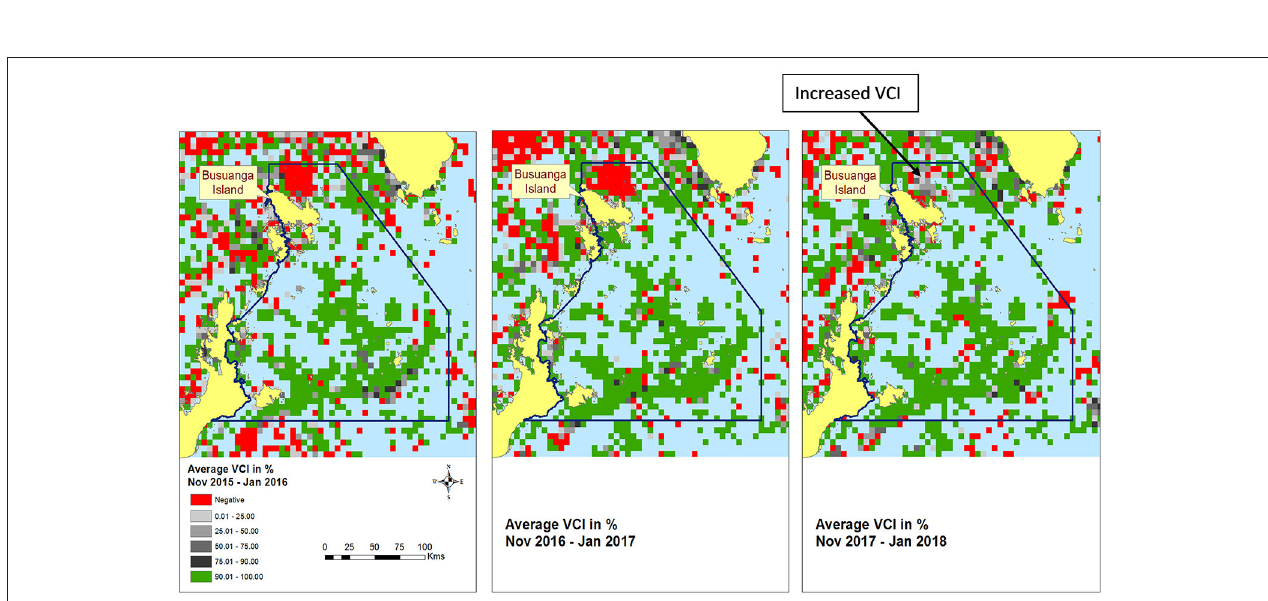
FIGURE 7 | Annual gridded VCI data for the Palawan round scad closure for the 2015, 2016, and 2017 seasons. A density slice is added to indicate zones with high compliance as green and negative VCI as red.